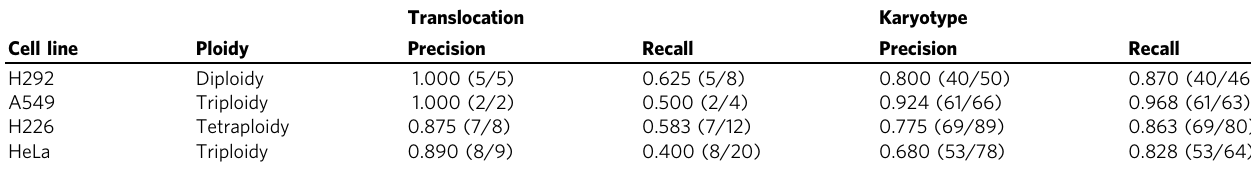
Table 1 Performance of karyotype reconstruction for cancer cell